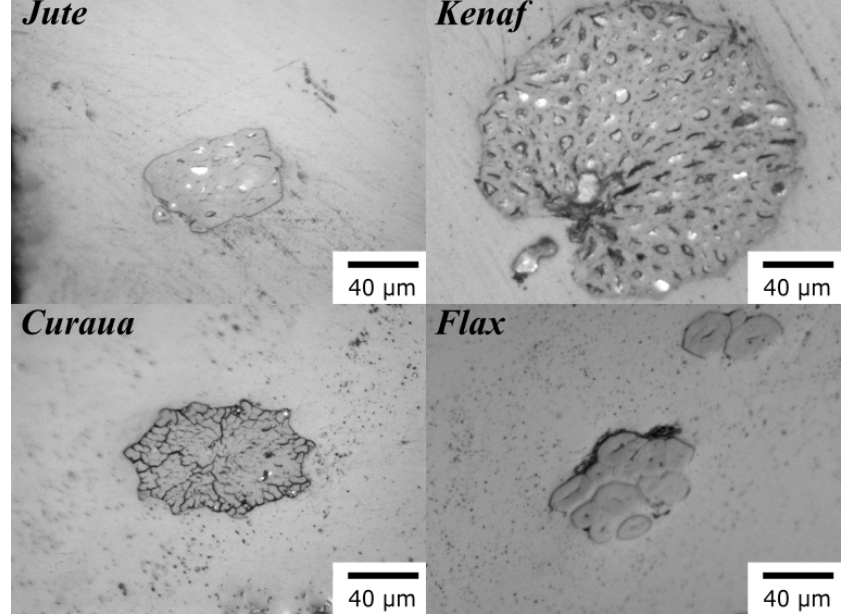
Figure 1. Cross-sectional optical microscopy images of jute, kenaf, curaua, and flax